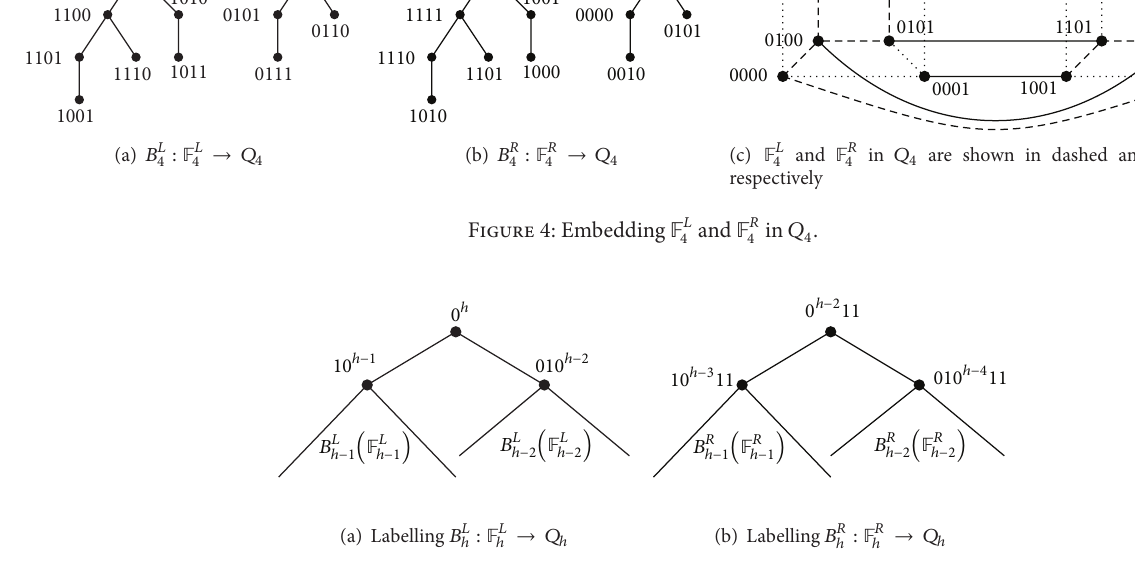
Figure 5: Two labellings 𝐵 𝐿 ℎ and 𝐵 𝑅 ℎ for F ℎ